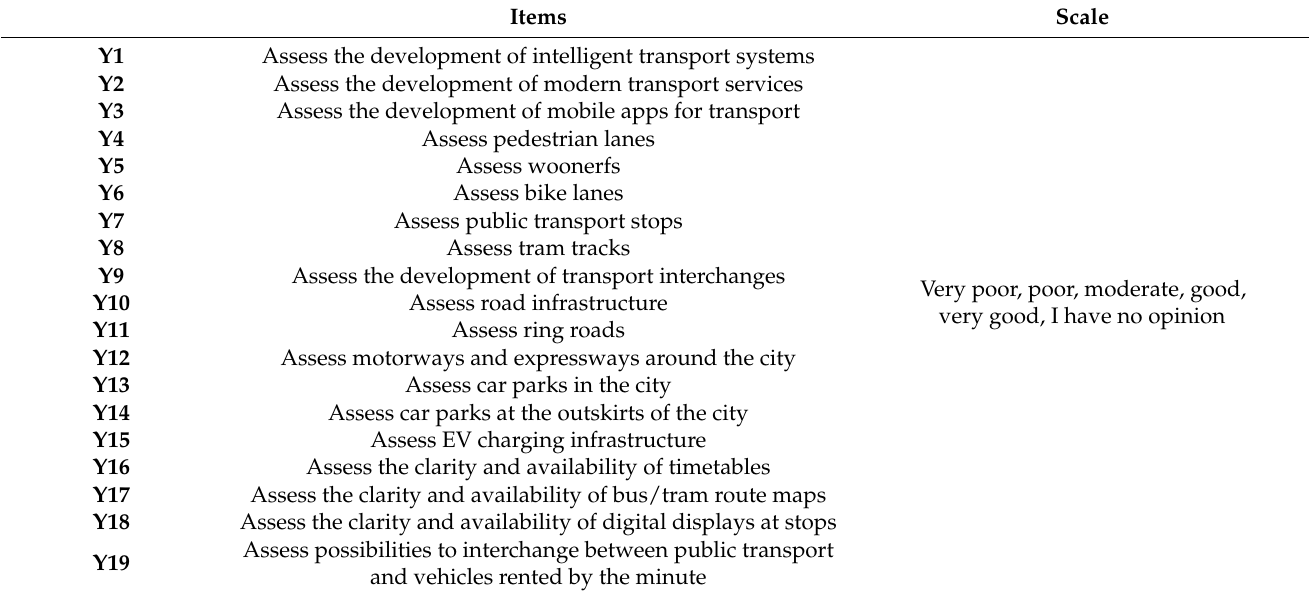
Table 3. Measurement scale for the development of sustainable, intelligent urban transport